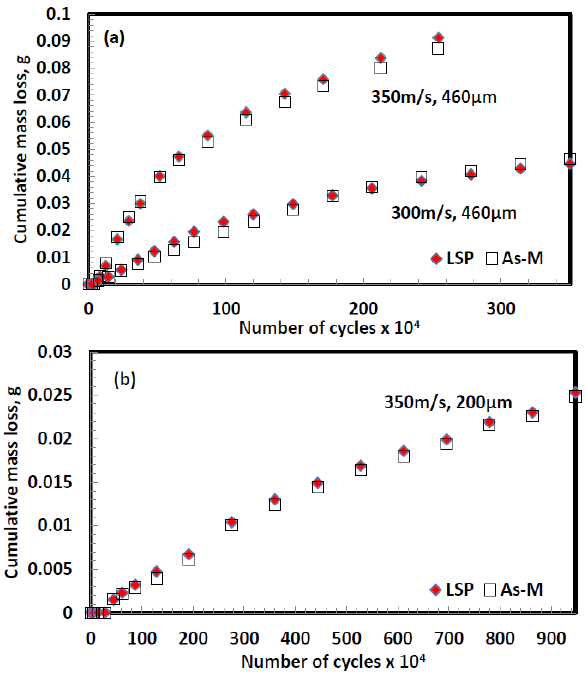
Figure 12. WDE curve of As ‐ M versus LSP for ( a ) 460 and ( b ) 200 μ m droplet sizes.